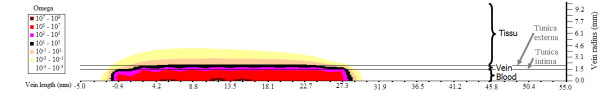
Isodamage distribution inside tissues: power: 15 W, pulse: 2s, delay: 2s, pull-back distance: 3 mm ; vein diameter: 3 mm; λ = 980 nm).